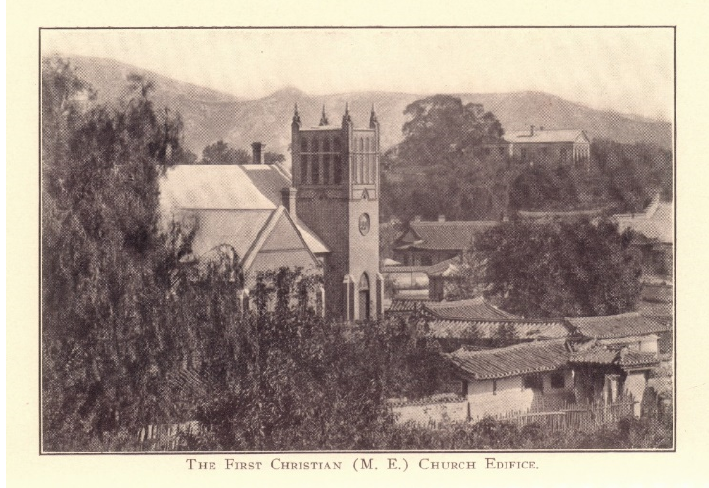
Figure 3. The First Christian Church at Chŏngdong in central Seoul, circa 1912. Sŏ 16943. After (Griffis 1912). Courtesy of Seoul Museum of History.